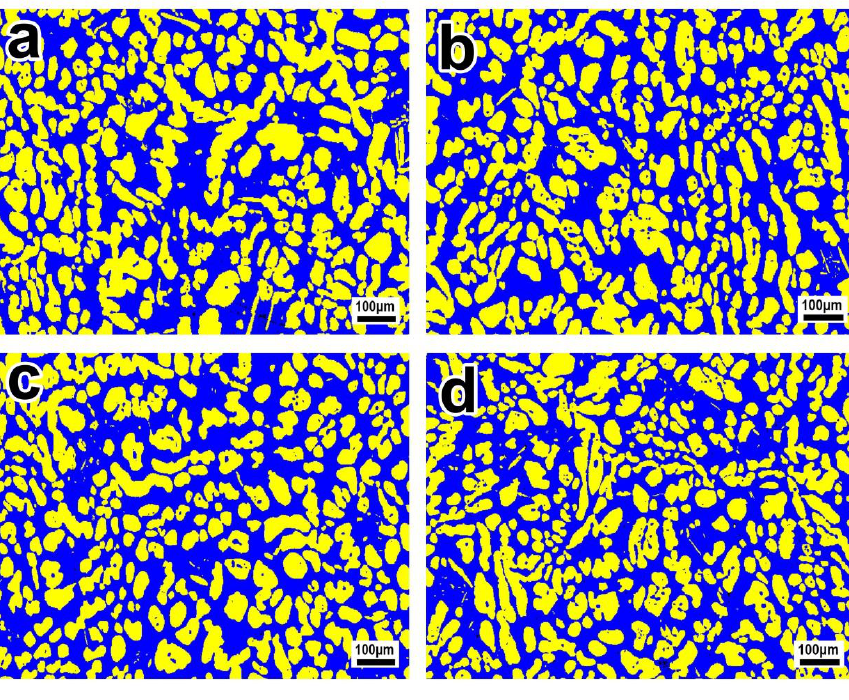
Figure 5. EBSD phase maps of S32750 stainless steel sample at different annealing times at 1050 °C: ( a ) 20, ( b ) 30, ( c ) 40, and ( d ) 60 min. The blue region is ferrite and the yellow region is austenite.